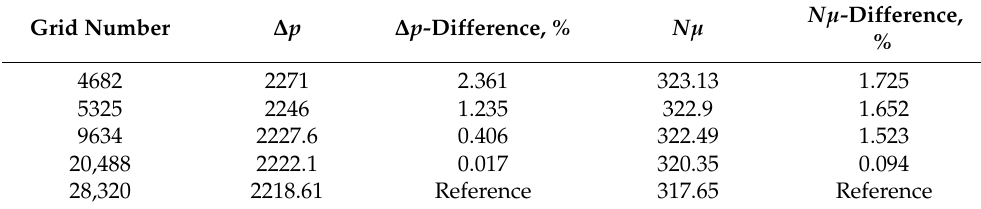
Table 1. The effect of mesh sizes on the Nusselt number and pressure difference.